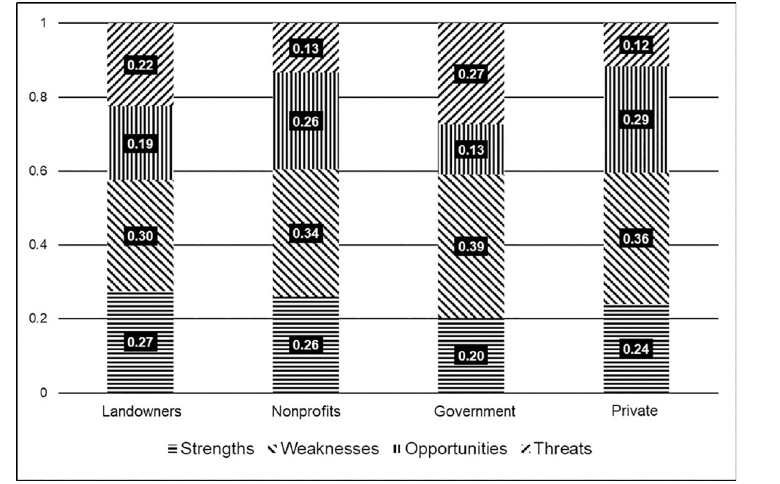
Fig 6. SWOT category factor priorities for each stakeholder